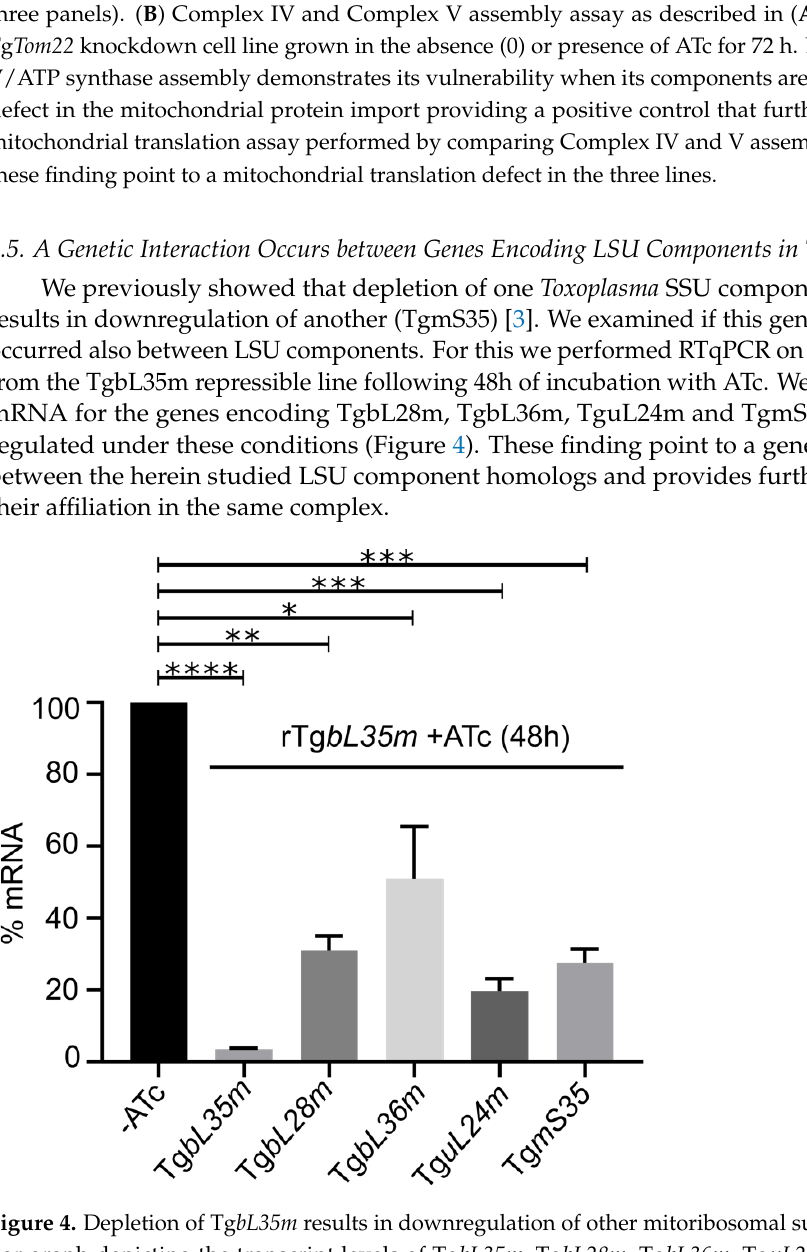
in the absence (0) or presence of ATc for 48, 72 or 96 h, separated by high resolution clear- native PAGE. Complex IV activity (top three panels) was visualized with cytochrome c: DAB staining. Complex V/ATP synthase assembly (middle three panels) was assayed by separating whole cell lysate from the respective cell lines on Blue-Native PAGE (BN-PAGE) followed by western blot using a commercial antibody raised against ATP synthase beta subunit (ATP Syn.), which is a part of complex V. Blots were also probed with anti-Tom40 antibody serving as loading control (lower three panels). ( B ) Complex IV and Complex V assembly assay as described in ( A ) performed on Tg Tom22 knockdown cell line grown in the absence (0) or presence of ATc for 72 h. Loss of Complex V/ATP synthase assembly demonstrates its vulnerability when its components are depleted due to defect in the mitochondrial protein import providing a positive control that further validates the mitochondrial translation assay performed by comparing Complex IV and V assembly. Collectively, these finding point to a mitochondrial translation defect in the three lines.